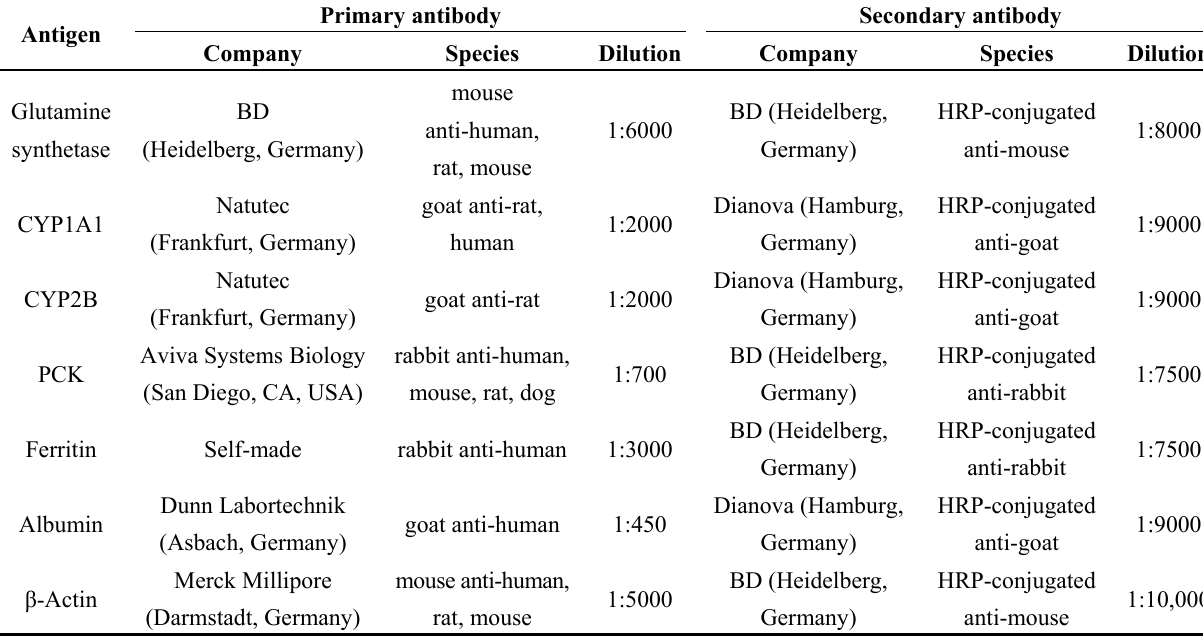
Table 3. Antibodies and dilutions used for Western blot